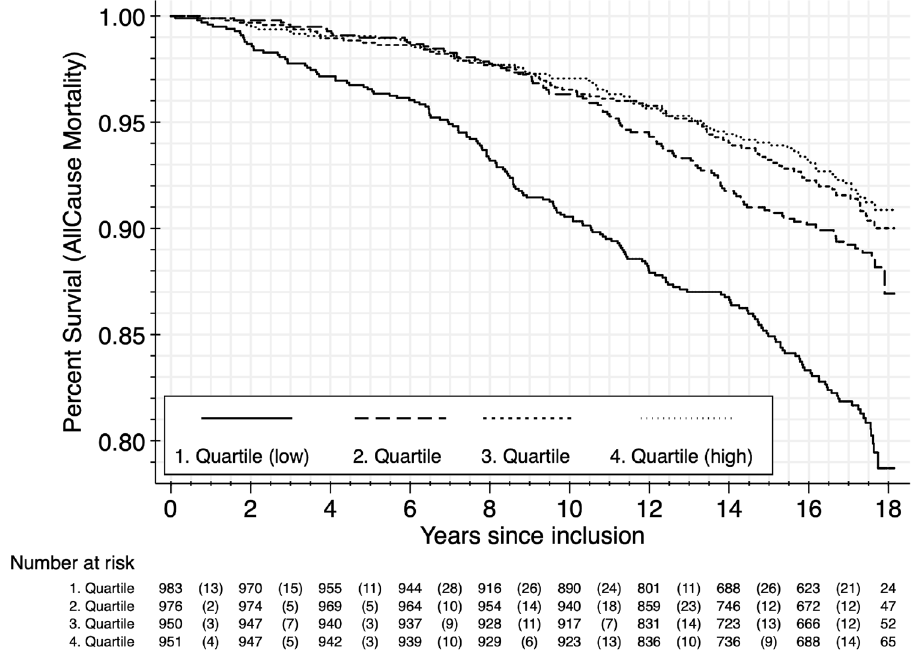
Figure 2. Kaplan–Meier survival function by NIM CRP quartile (Observations N = 3860, No. of deaths = 429). At the End of the observation period (18 years) 79% survived in the belonging to the lowest quartile of NIM-Ratio (0.594–0.977) and 91% survived in the highest quartile of NIM-Ratio (1.027–2.001) (Log-rank test for equality of survivor functions: chi 2 (3) 68.51; p <